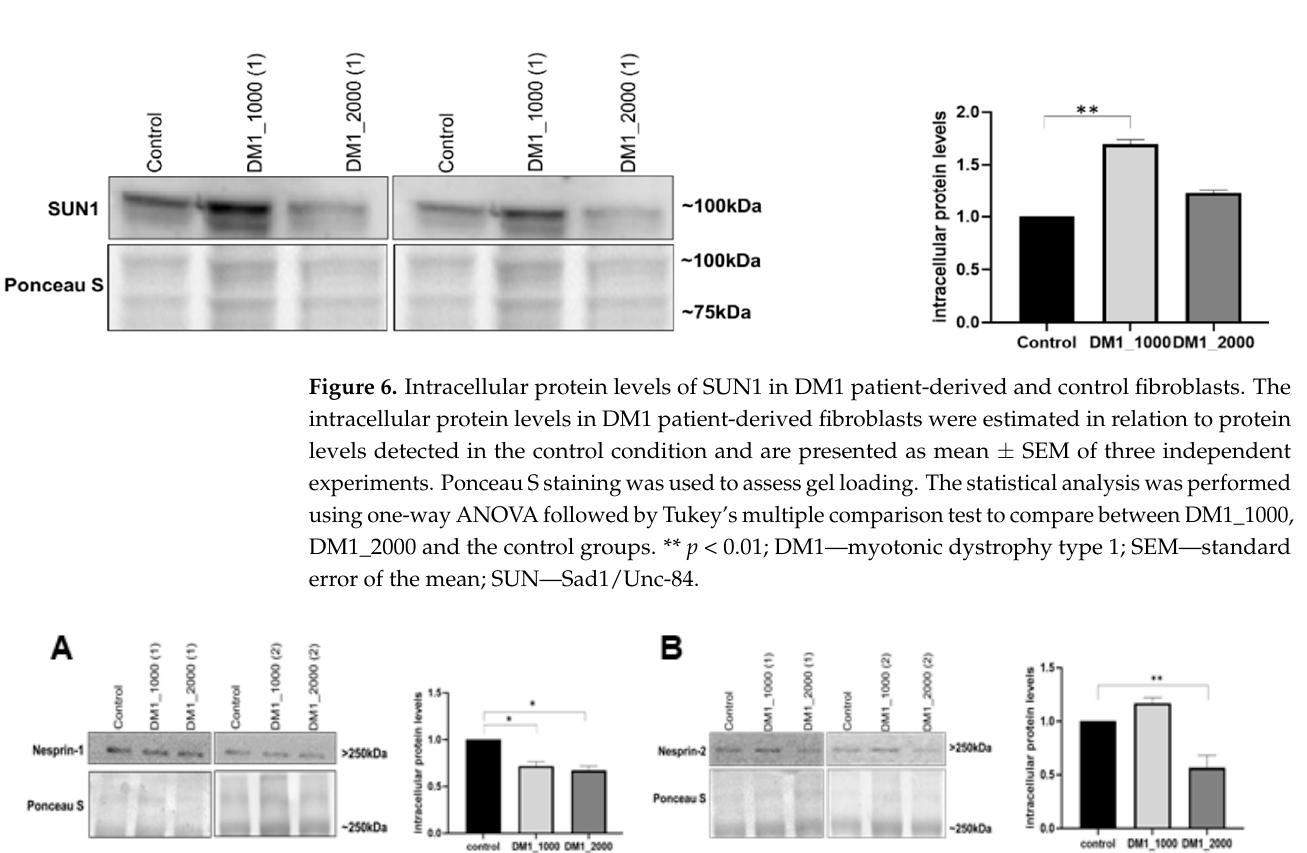
Figure 5. Intracellular protein levels and nuclear localization of LAP1 in DM1 patient-derived and control fibroblasts . ( A ) Total LAP1, LAP1B and LAP1C intracellular protein levels in DM1 patient- derived and control fibroblasts. The intracellular protein levels in DM1 patient-derived fibroblasts were estimated in relation to protein levels detected in the control condition and are presented as mean ± SEM of four independent experiments. Ponceau S staining was used to assess gel loading.